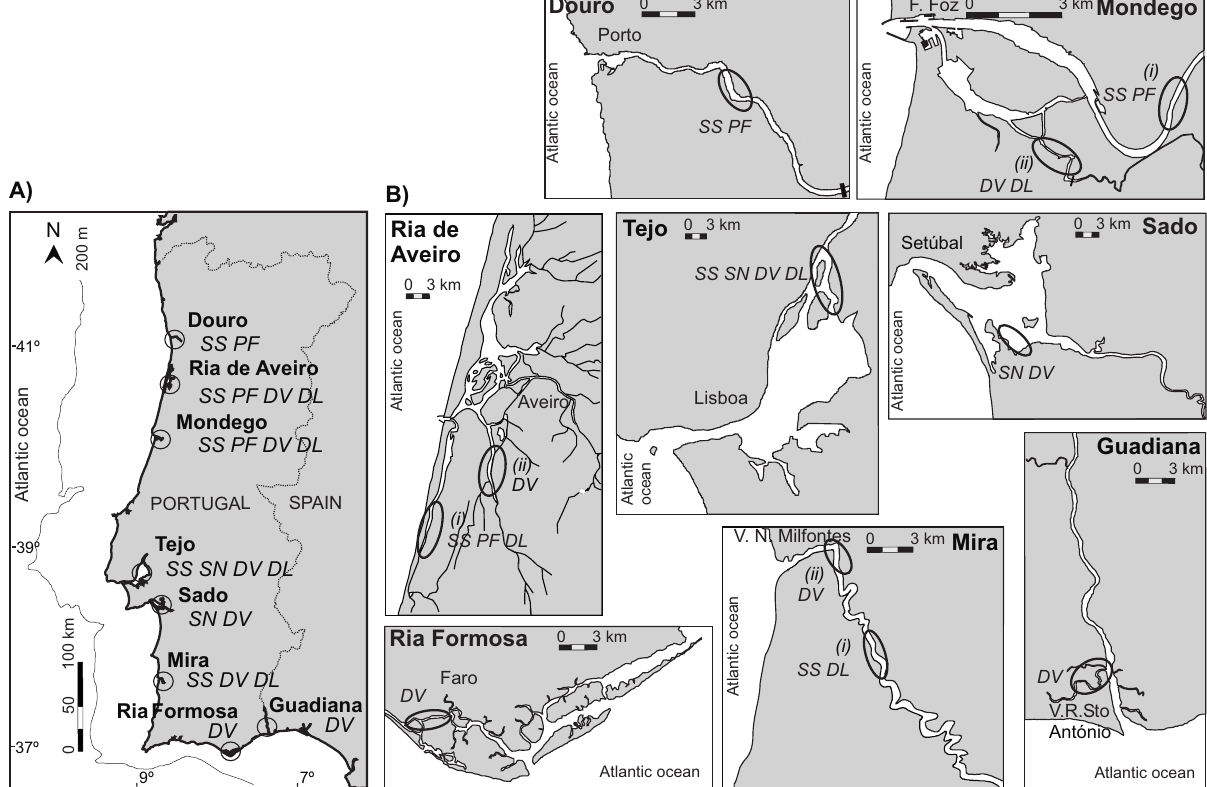
Fig . 1. – Map of Portugal and sampled estuarine nursery sites. A, location of estuarine systems sampled along the Portuguese coast and fish species sampled in each system: Solea solea ( SS ), Solea senegalensis ( SN ), Platichthys flesus ( PF ), Diplodus vulgaris ( DV ) and Dicentrarchus labrax ( DL ). B, location of sampled sites within each estuary - within the Ria de Aveiro, Mondego and Mira estuaries, distinct nursery areas were sampled for different species and are represented by i and ii